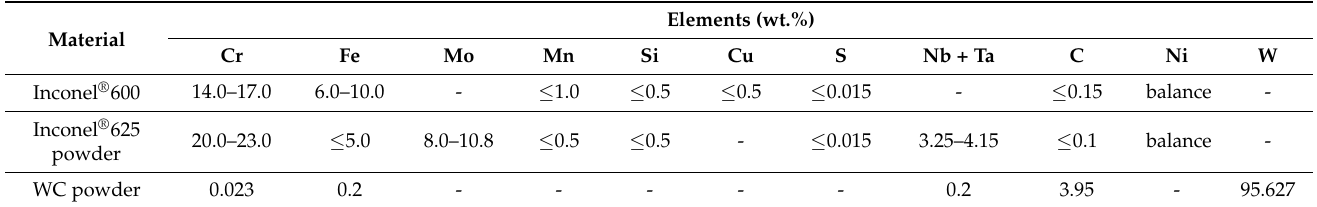
Table 1. Chemical composition of Inconel ® 600-alloy used as a substrate material and WC and Inconel ® 625-alloy powders used as alloying material. Elements